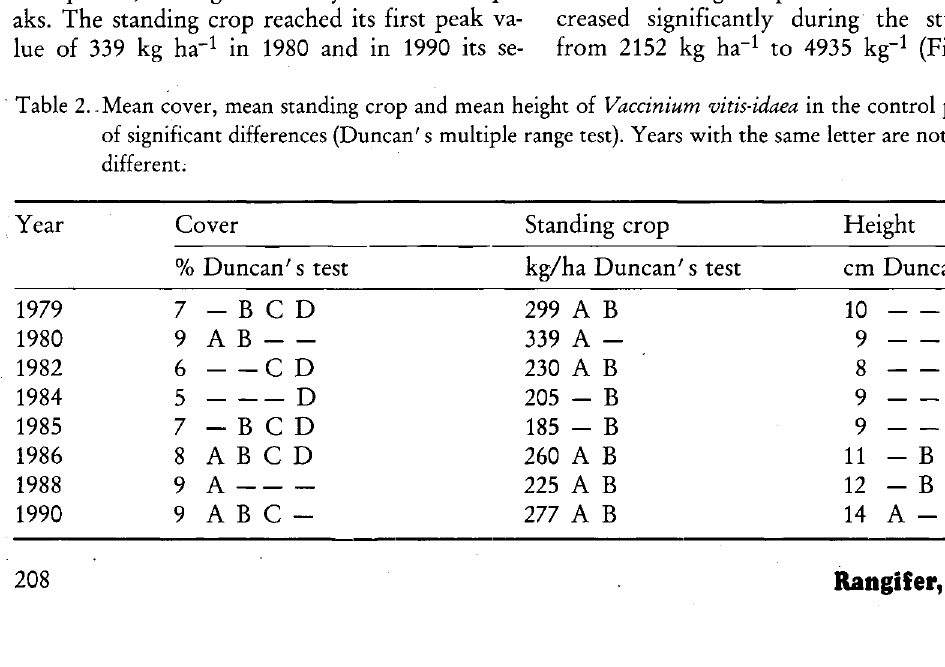
Table 2.-Mean cover, mean standing crop and mean height of Vaccinium vitis-idaea in the control plots and test of significant differences (Duncan's multiple range test). Years with the same letter are not significantly